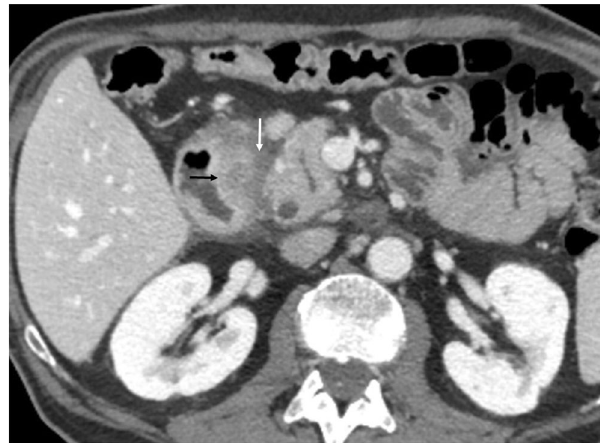
Fig. 15 A 48-year-old man with epigastric pain. Contrast-enhanced CT identifies subtle infiltration of soft tissue (white arrow) in the pancreaticoduodenal groove. Duodenal mural thickening secondary to edema is observed on the medial side (black arrow). Note the normal enhancement of the pancreatic head and absence of classic signs of exsudative